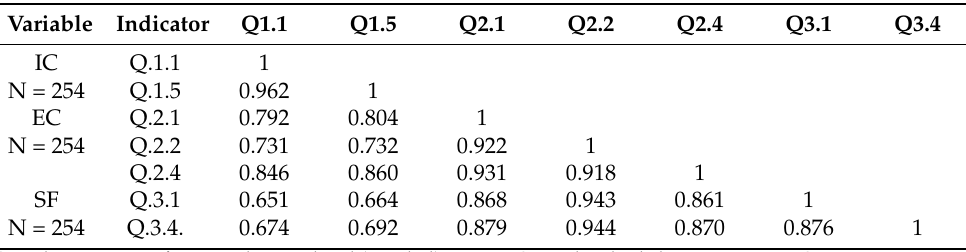
Table 11. Correlation matrix of major